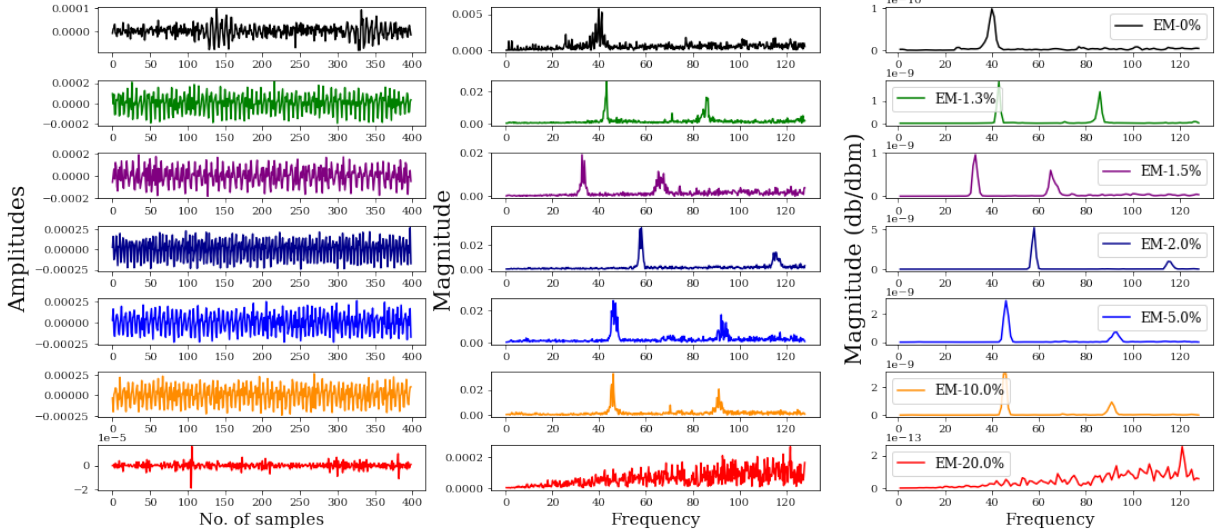
Figure A6. CR differentials and their FFT and PSD outputs at 900 RPM for the emulsion